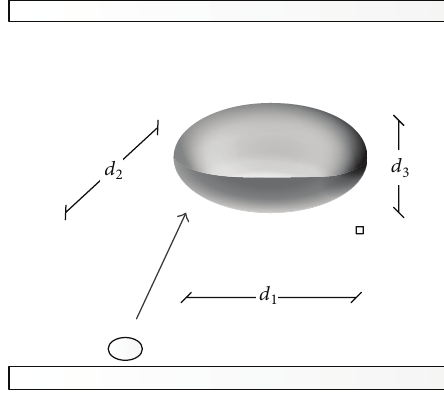
Figure 5: Shape parameter of particle.